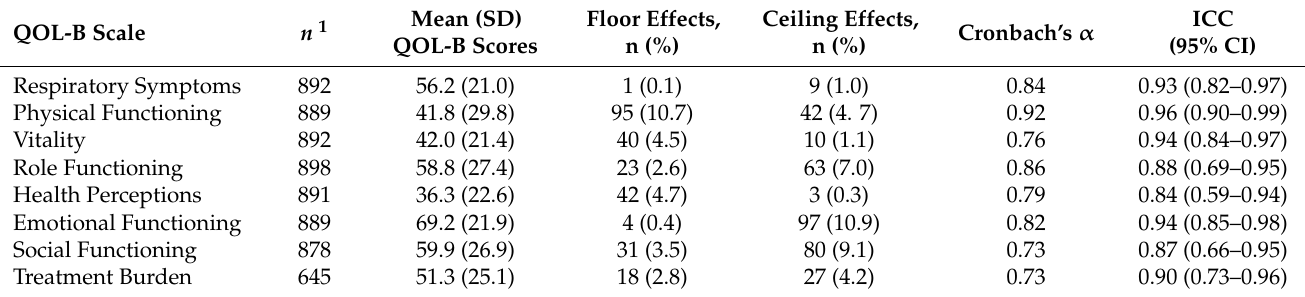
Table 2. QOL-B scores at baseline, floor and ceiling effects, internal consistency and test-retest reliability.